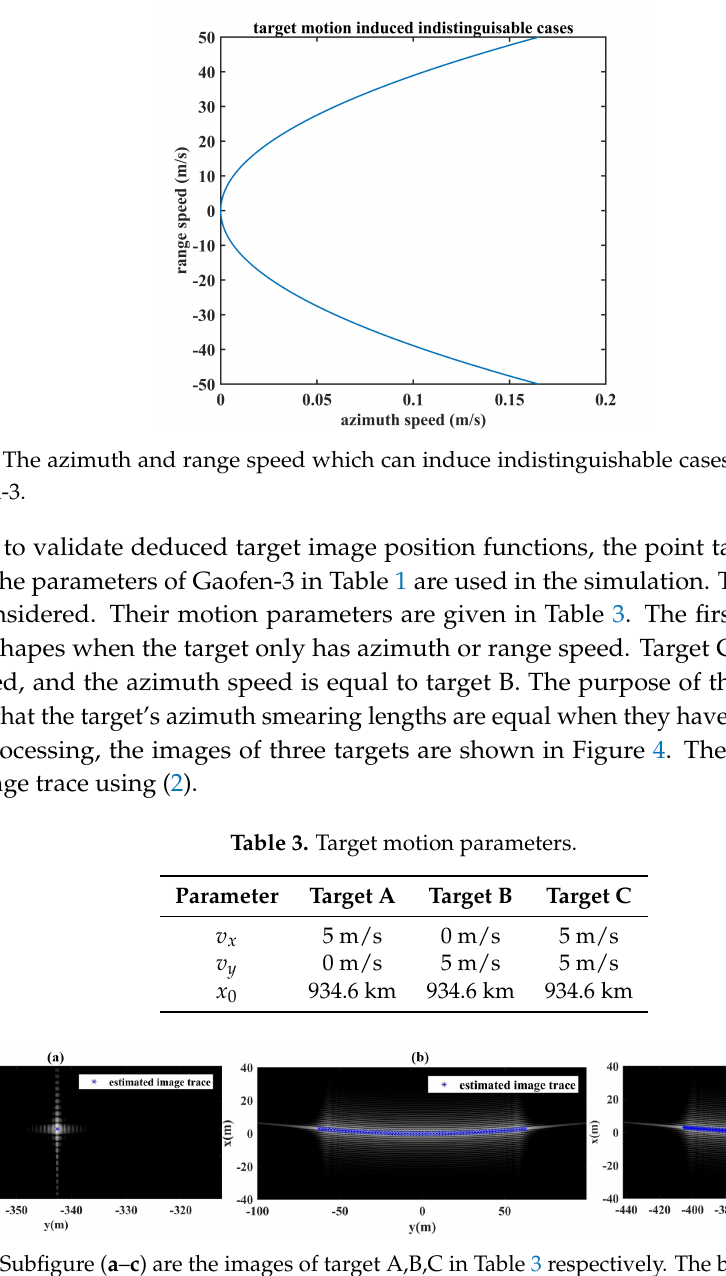
Figure 4. Subfigure ( a – c ) are the images of target A,B,C in Table 3 respectively. The blue ‘*’ denotes the calculated image